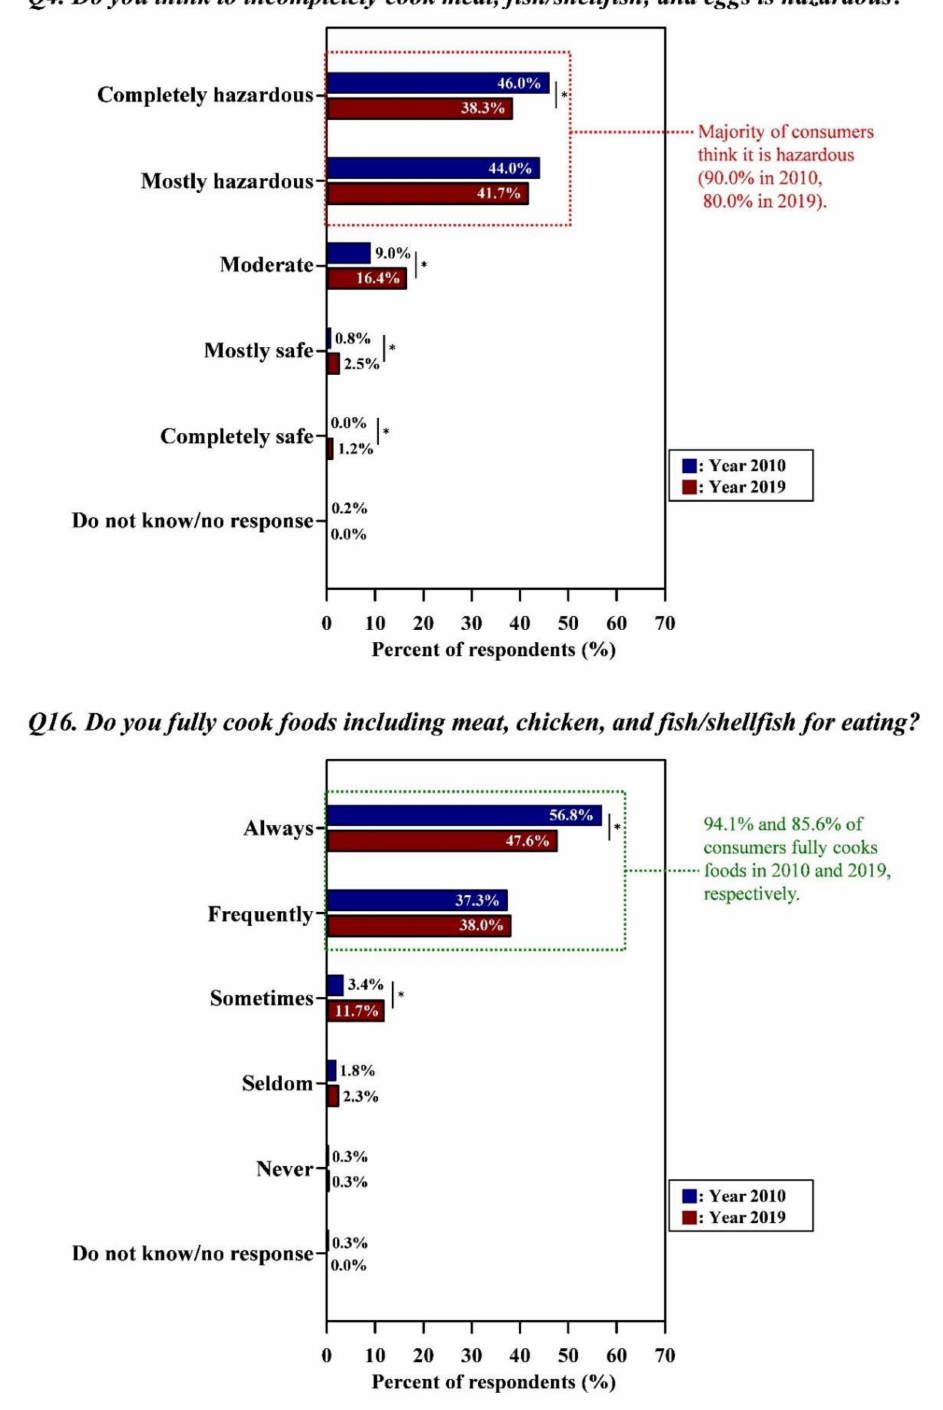
Figure 5. Proper behaviors of consumers in accordance with their perceptions regarding incomplete cooking. Asterisk (*) indicated between graphs means the significant di ff erences of responses (the Kruskal–Wallis test; p < 0.05) in each answer option from Year 2010 and Year 2019. Green letters indicated the proper risk perceptions (i.e., the correct response in line with conventional food safety guidelines) and behaviors of consumers. All data regarding the percentage of the combined answer options (e.g., Always + Frequently) are provided in Table